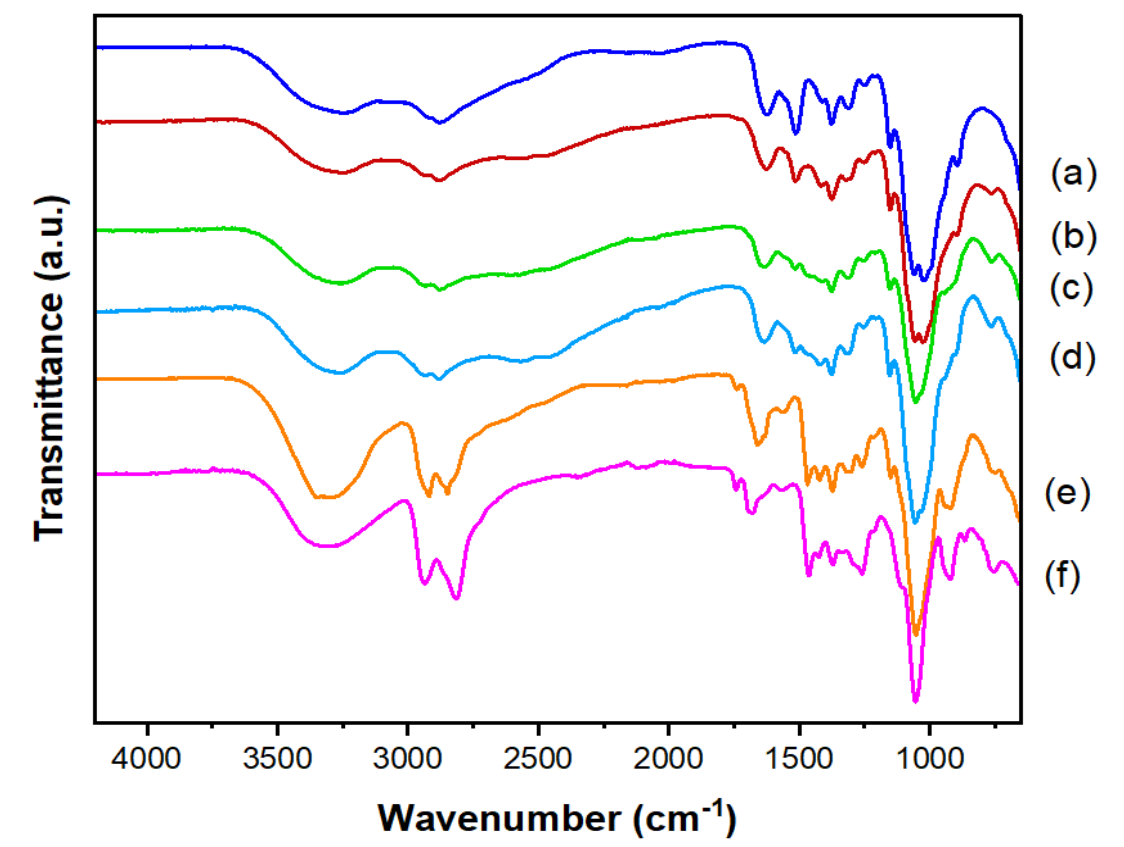
Figure 5. FTIR spectra of CHI (a), their blends (b–e), and P3HPEI (f). Content of P3HPEI in the blends: 20 (b), 40 (c), 60 (d), and 80% (e). Table 1. FTIR absorption bands in CHI/ P3HPEI blends and their assignment.